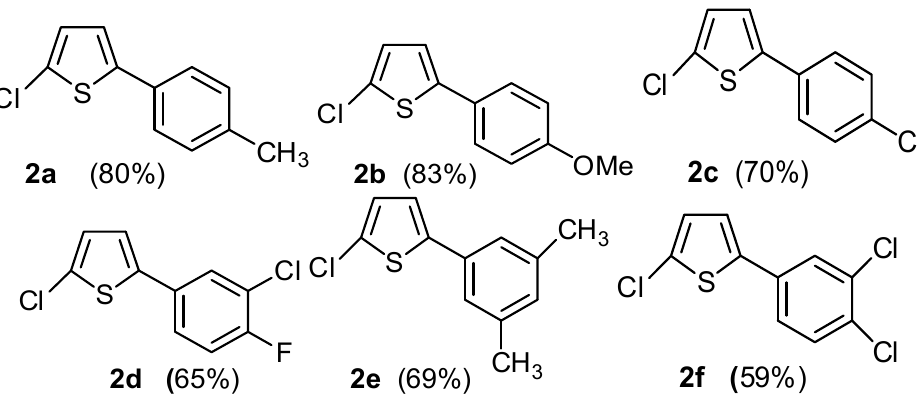
Figure 1. Scope of the compounds 2a – f .